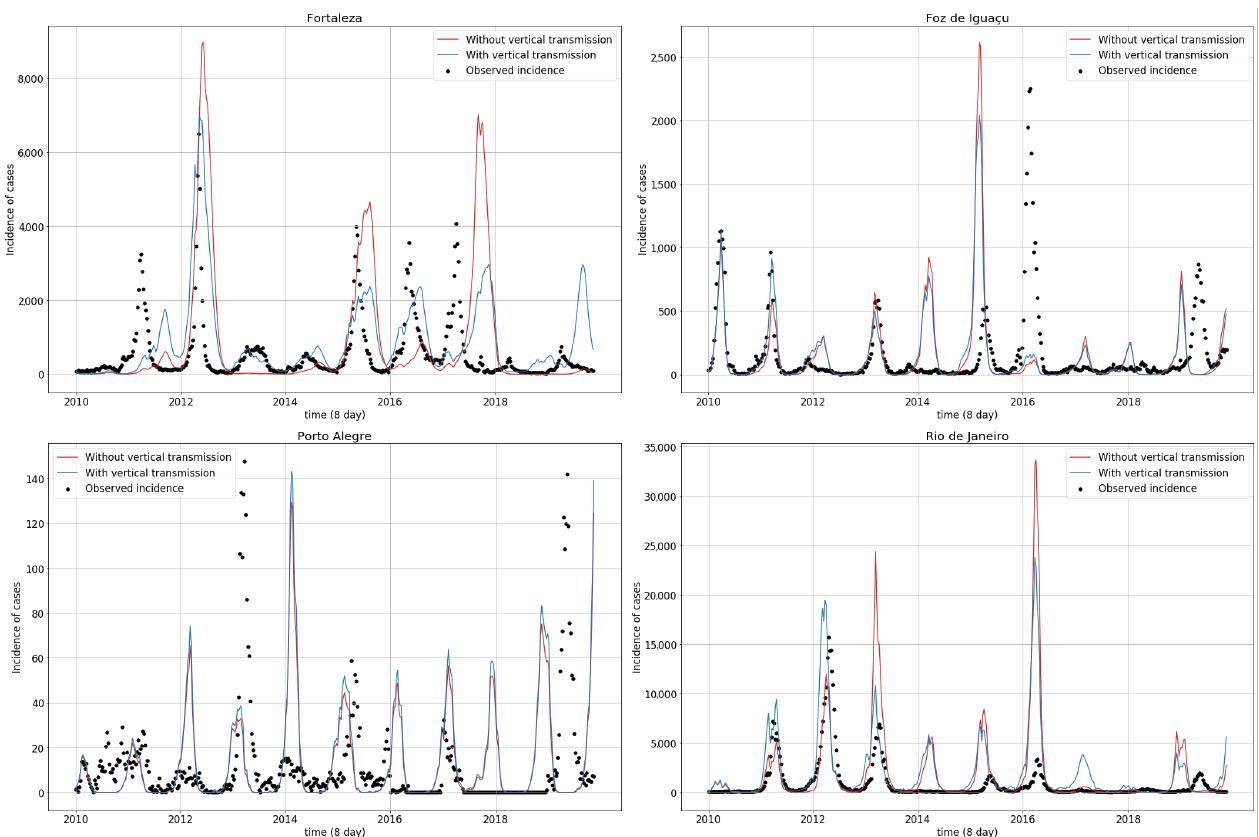
Figure 5. Observed (dots) and simulated (solid line) dengue incidence time series, with (blue lines) and without (red lines) vertical transmission, for the four studied municipalities. Parameter values used in the simulations are shown in Table 4. Figure 6 indicates the influence of vertical transmission on attack rates.